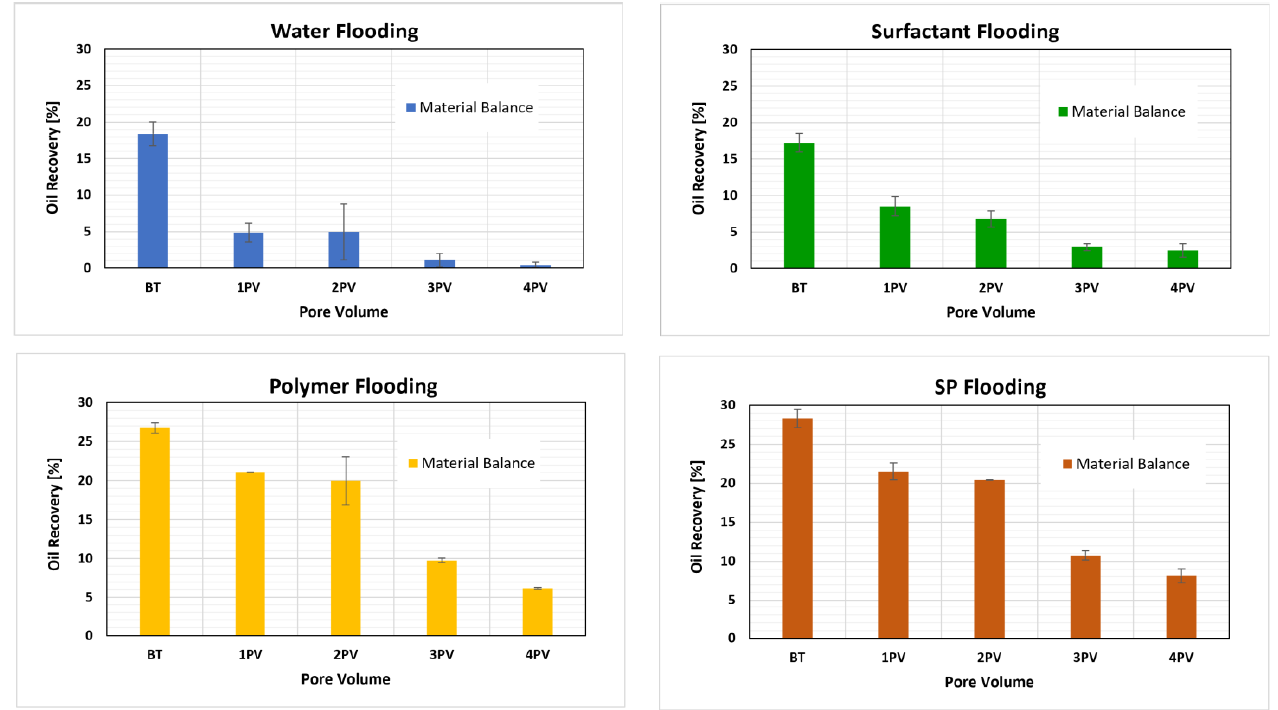
Figure 5. Error bars for the repeated tests in heavy oil displacements by water, surfactant, polymer, and SP.